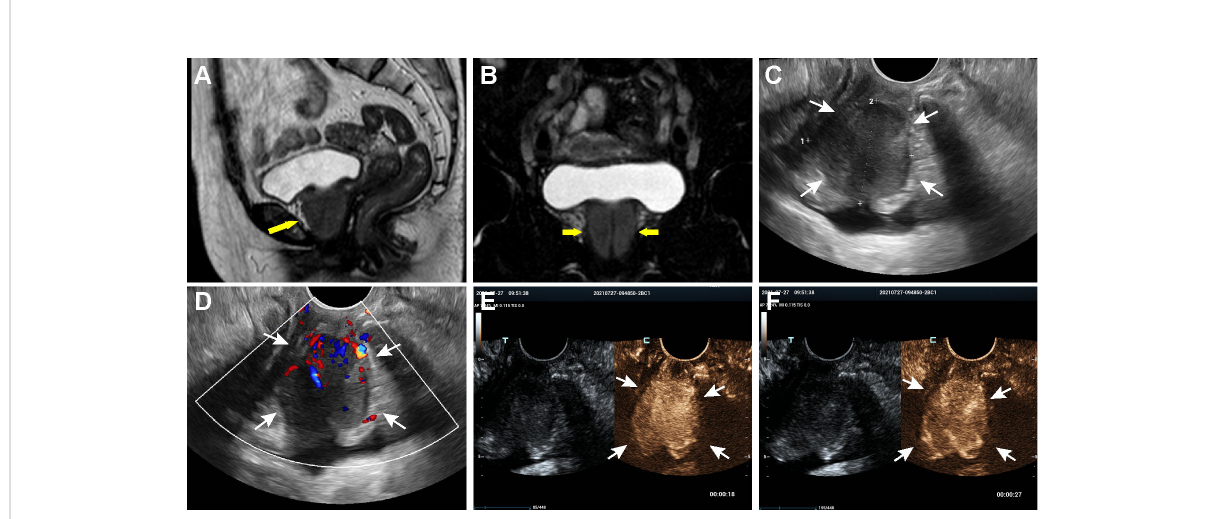
FIGURE 1 MRI, US and CEUS fi ndings of the periurethral mass on admission. (A, B) Coronal and sagittal MRI of the pelvis, showing a well-de fi ned mass around the urethra (arrows). (C, D) Transvaginal ultrasonography scan revealed a heterogeneously low echoic mass encasing urethra and color Doppler imaging indicated abundant blood fl ow signals in the lesion. (E) CEUS image obtained at the 18 sec after contrast injection indicating an overall heterogeneously high enhancement of the mass in the arterial phase. (F) CEUS image obtained at the 27 sec showed quick wash-out of the contrast in the